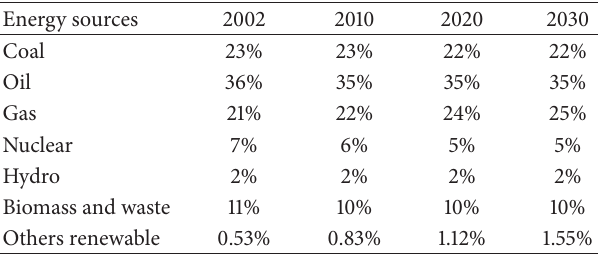
Table 3: World primary energy demand (%) from 2002 to 2030